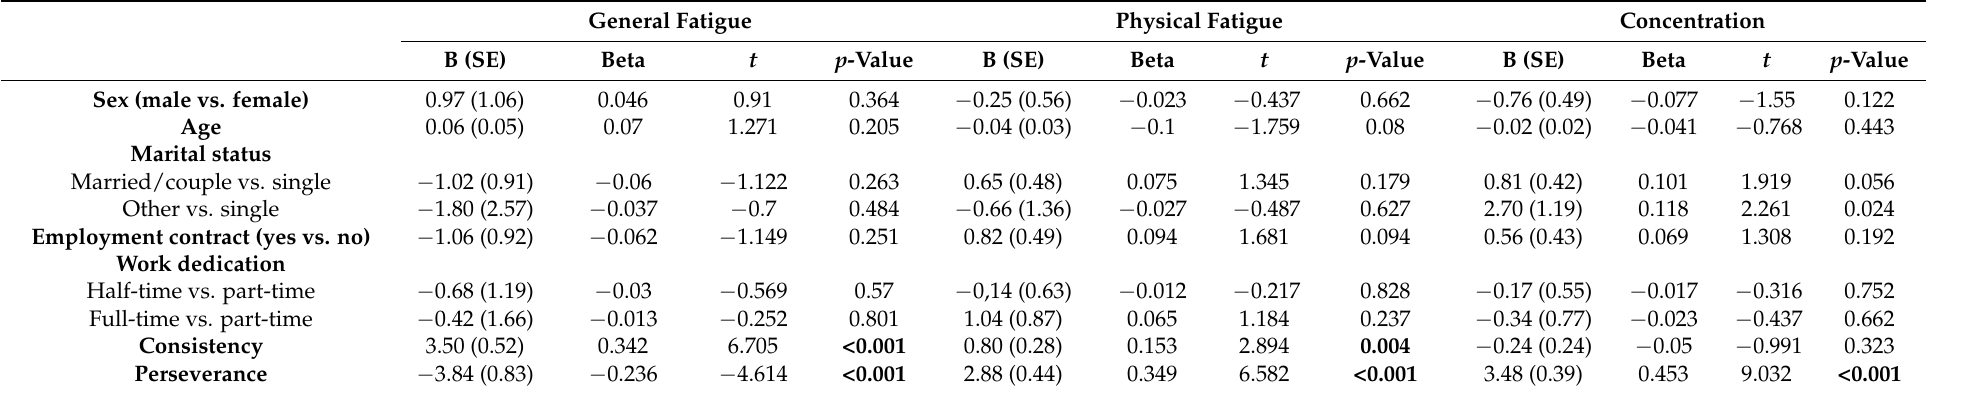
Table 5. Linear regression model of variables and subscales on general fatigue, physical fatigue, and